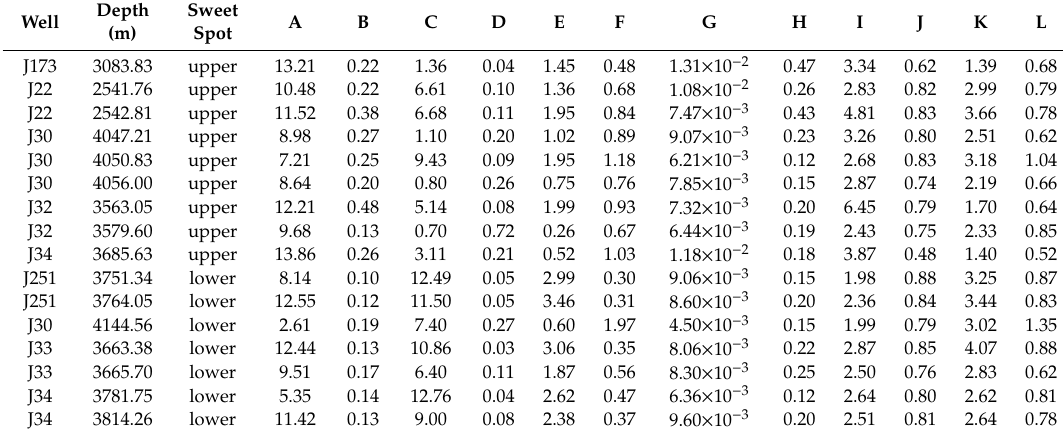
Table 2. Element geochemistry parameters of Lucaogou Formation source rocks in Jimsar